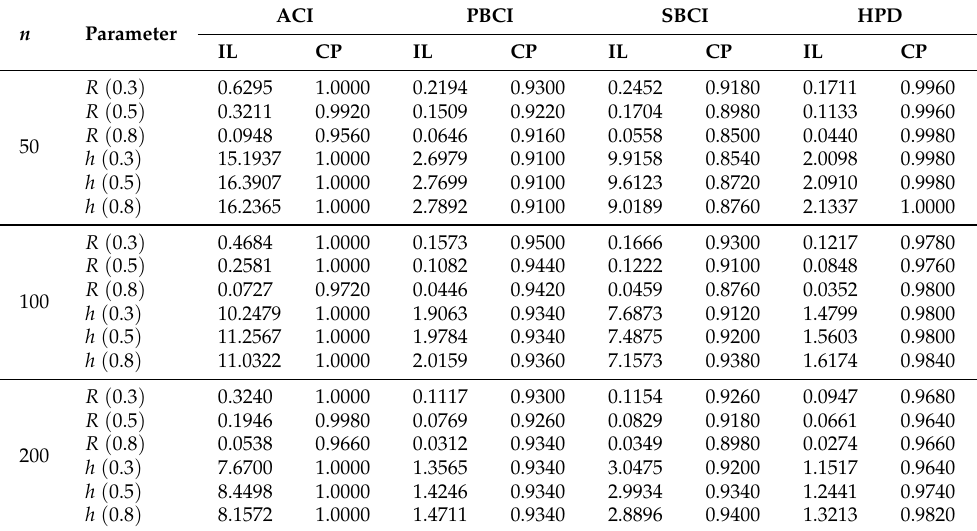
Table 10. Interval estimates of R ( x ) and h ( x ) at x = { 0.3,0.5,0.8 } under Scheme